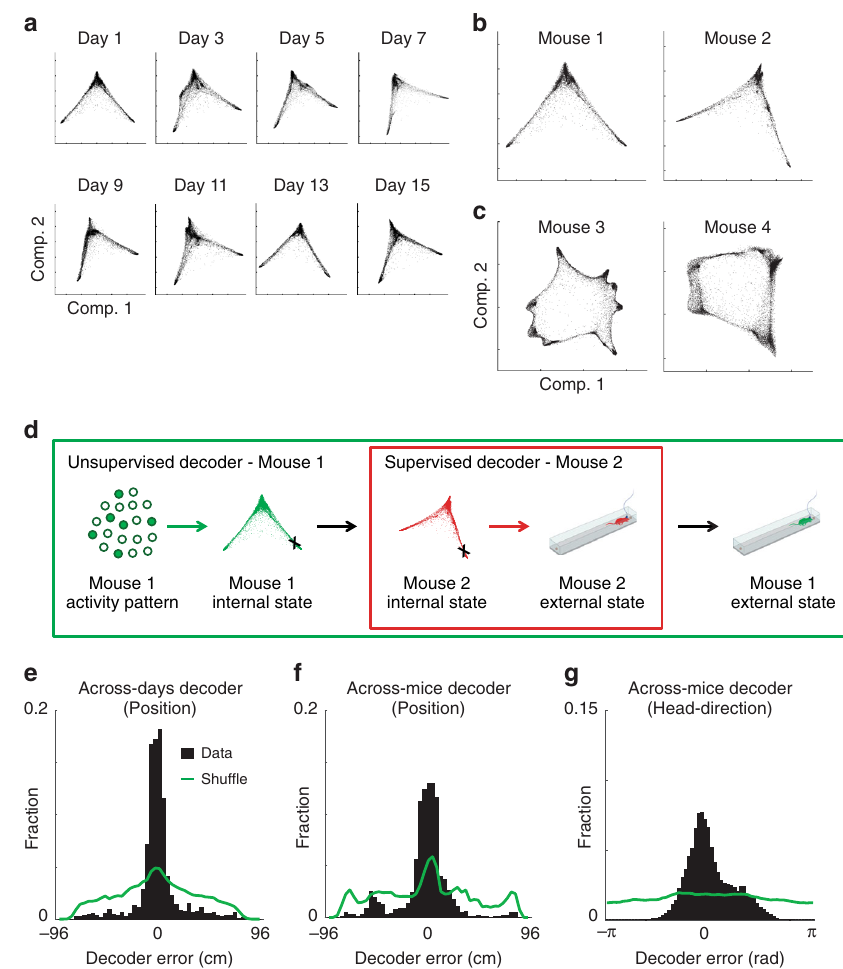
Fig. 5 The internal structure of neuronal activity is maintained across days and across mice. a The distribution of data points in the reduced dimensional space of neuronal activity for hippocampal data from eight different days of the experiment. Note that the distribution of data points maintains a similar structure across days. b , c The distribution of points in the reduced dimensional space of neuronal activity for hippocampal data ( b ) and ADn/PoS data ( c ) from two different mice. d Work fl ow for the across-mice decoder. Neuronal activity in mouse 1 is associated with a speci fi c network state within its internal structure of neuronal activity. Based on the similarity between internal structures, an analogous network state is found in mouse 2. This network state of mouse 2 is associated with a known external state. The decoded external state of mouse 1 is set as the same associated external state of mouse 2. e – g Distribution of decoding error for the across-days decoder for hippocampal data ( e ), the across-mice decoder for hippocampal data ( f ), and the across- mice decoder for ADn/PoS data ( g